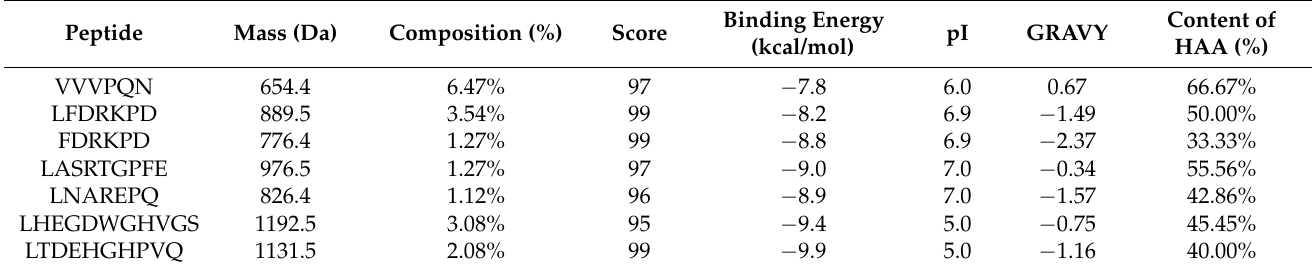
Figure 5. The MS/MS spectrum of the peptide VVVPQN. 3.3. Inhibitory Pattern of VVVPQN The inhibition pattern of VVVPQN was analyzed by a Lineweaver–Burk plot with four concentrations of substrate (2, 3, 4, and 5 mmol ∙ L − 1 HHL) and three concentrations of